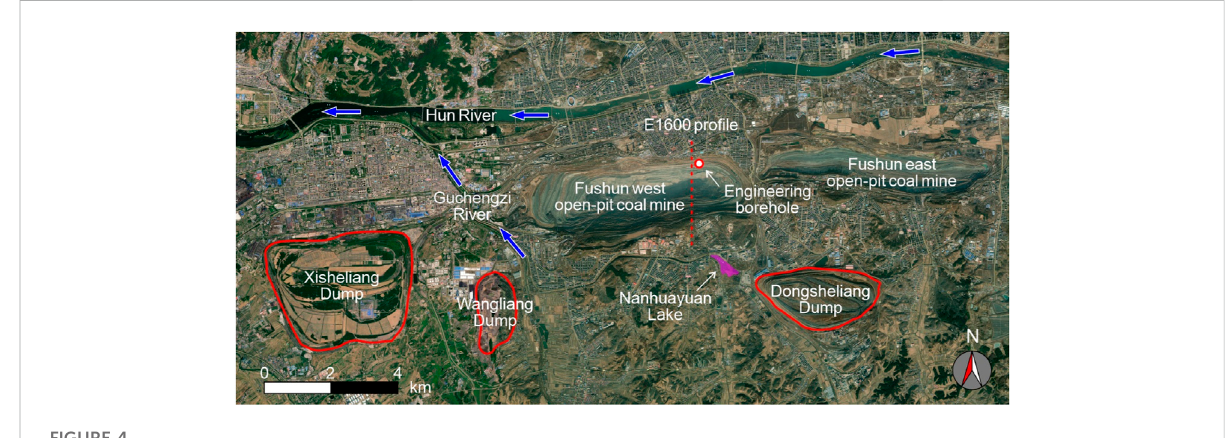
FIGURE 4 Satellite image of the Fushun West Open-Pit coal